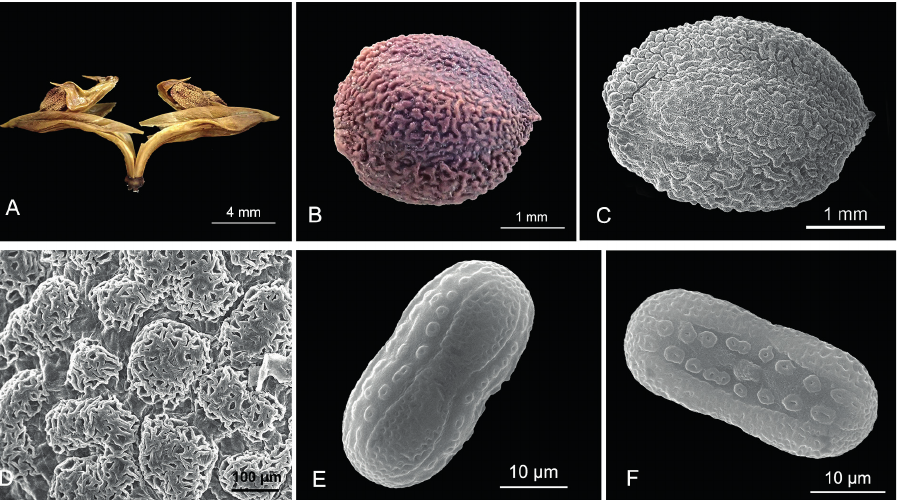
Figure 2. Fruit, seed and pollen morphology of Rungia fangdingiana sp. nov. A dehiscent capsule (show- ing the rising placenta and seeds) B seed C seed testa (SEM) D detail of the verrucae of seed testa (SEM) E interapertural view of pollen grain F apertural view of pollen grain. Photos by Zhe-Li